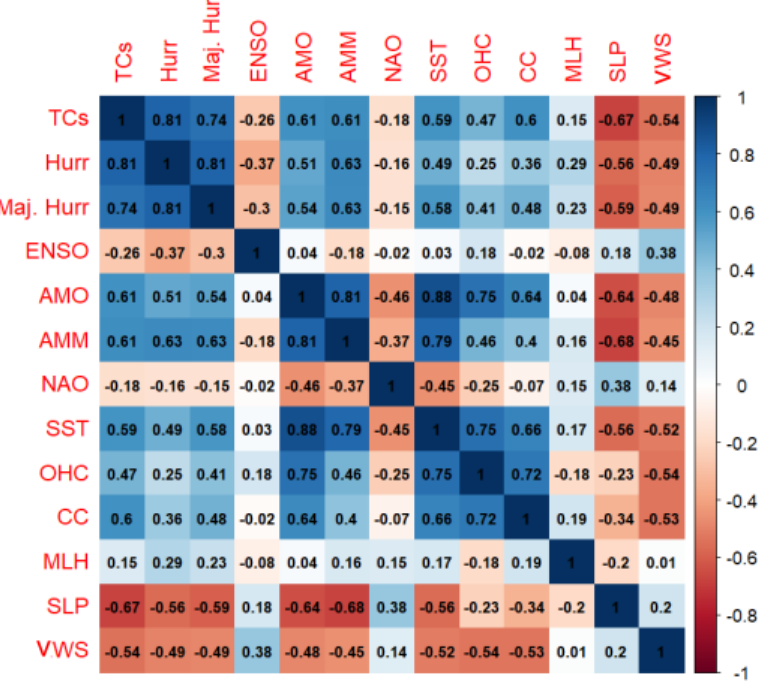
Figure 3. Results of Pearson’s correlation tests between all dependent and independent variables.